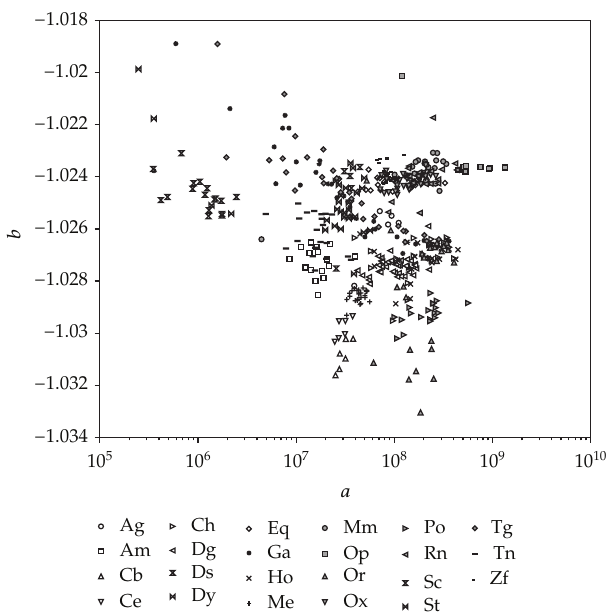
Figure 8: Locus (cid:5) a,b (cid:6) of the power law parameters for the 463 chromosomes and n (cid:7) { 1 , ... , 8 }